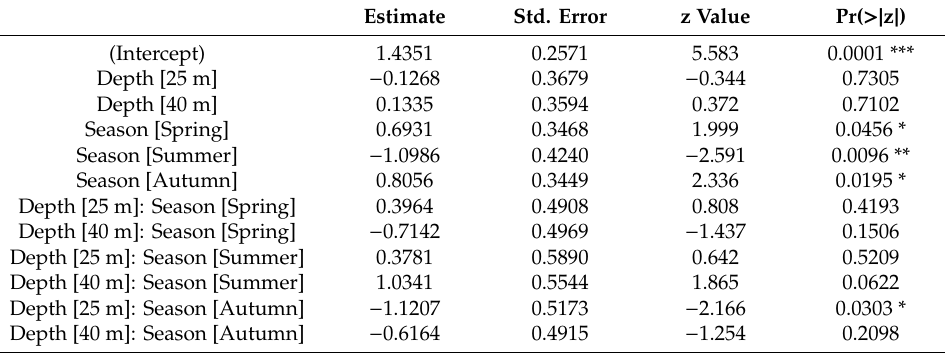
Table 3. Summary of the mixed-e ff ects GLM testing the e ff ects of the fixed factors “Depth” (18, 25 and 40 m) and “Season” on the abundance of Nanocassiope melanodactylus . The contribution of “Year” is not presented, as this was a random source of variation. Reference values were 18m for “Depth” and winter for “Season”.